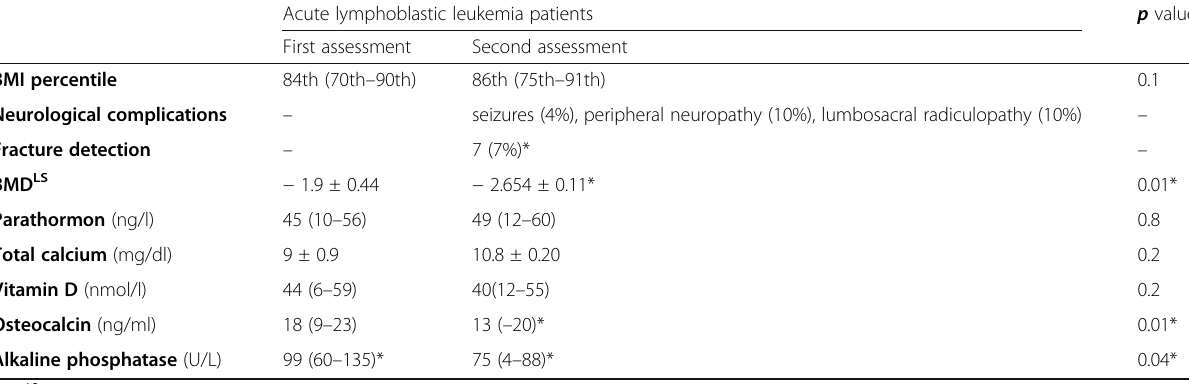
Table 3 Comparing clinical and laboratory data of the patients at diagnosis (first assessment) and after 3 years (second